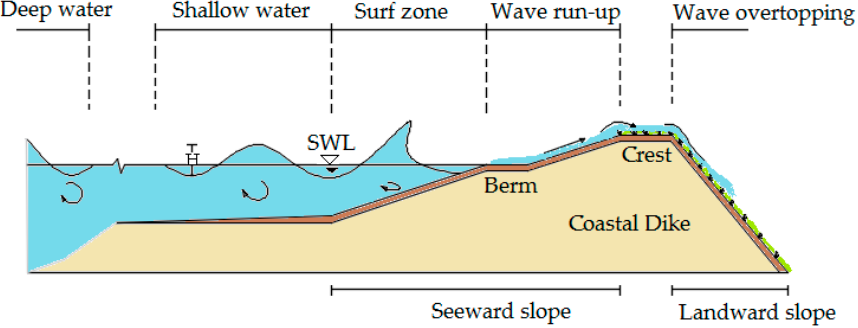
Figure 1. Definition sketch of wave run-up on coastal dikes.